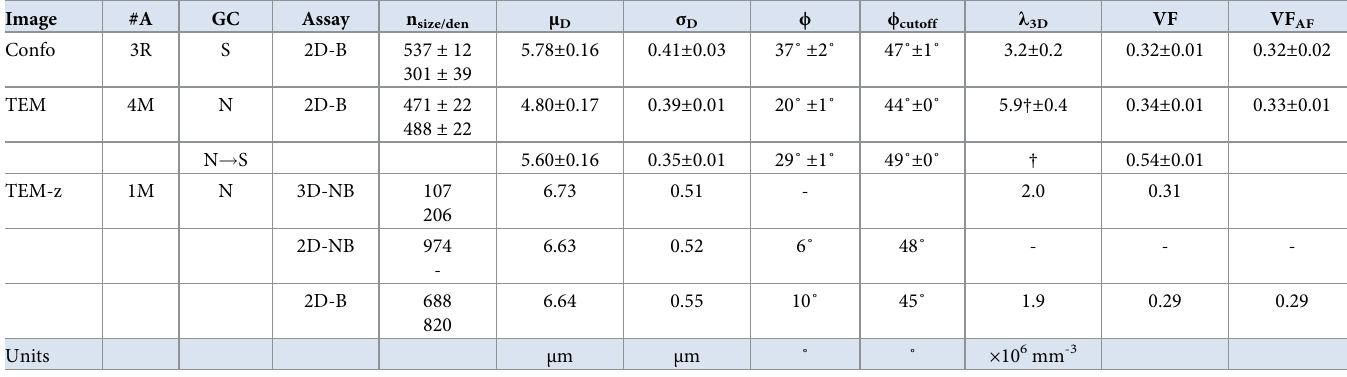
Table 3. Summary of size and density analysis of cerebellar GC somata and nuclei.